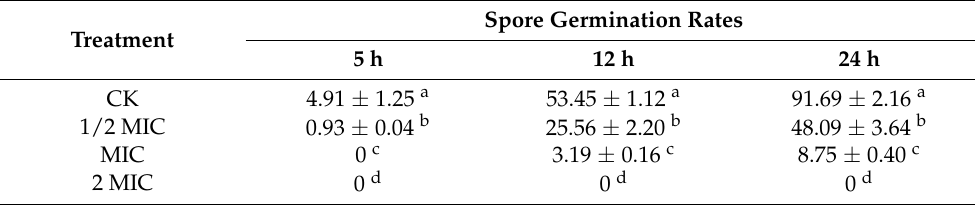
Table 4. Effect of different concentrations of a PCT nanoemulsion on spore germination of P. italicum .